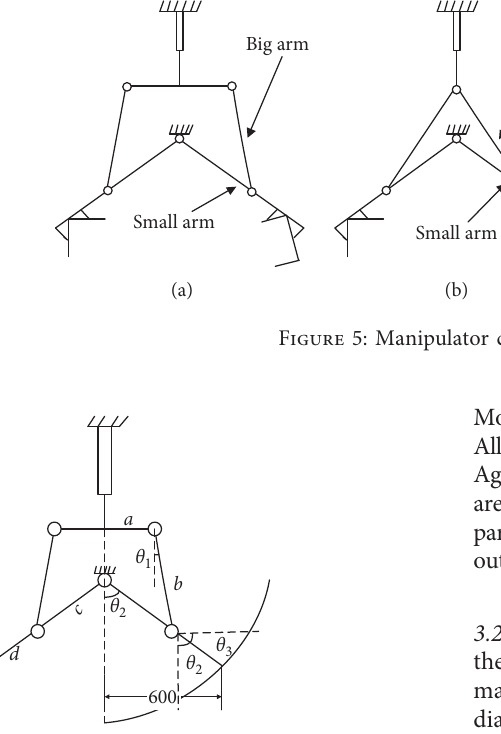
Figure 6: Manipulator